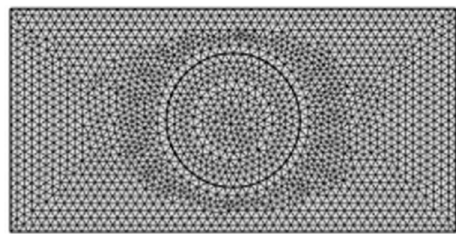
Figure 8. Model Grid Division.